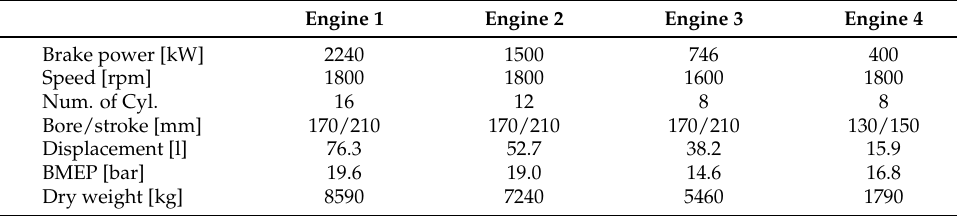
Table 2. Main features of the engine models considered in this study.